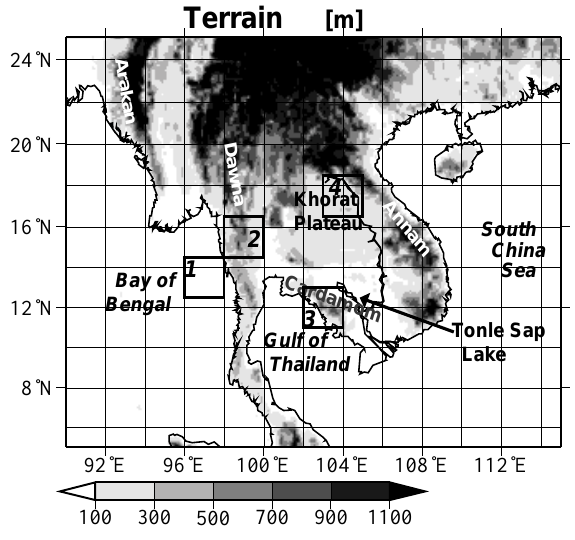
Fig. 1. Terrain elevation and geography of the study area. The gray shade indicates terrain elevation. The rectangles with number (one to four) are the averaged area in Fig. 3.